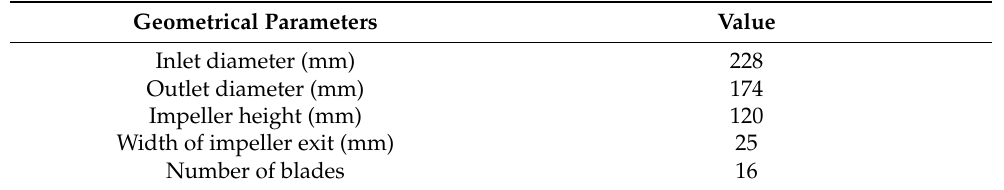
Figure 1. ( a ) Geometry of the centrifugal compressor; ( b ) Cross-sectional diagram showing the cen- trifugal compressor at x = 0 mm and z = −12 mm; ( c ) Description of orientations in the work. Table 1. Main geometrical parameters of the centrifugal compressor. Table 1. Main geometrical parameters of the centrifugal compressor.